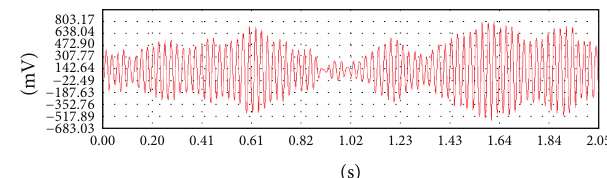
Figure 15: Voltage of the control current when the mean wind velocity 𝑉 = 6 m/s.